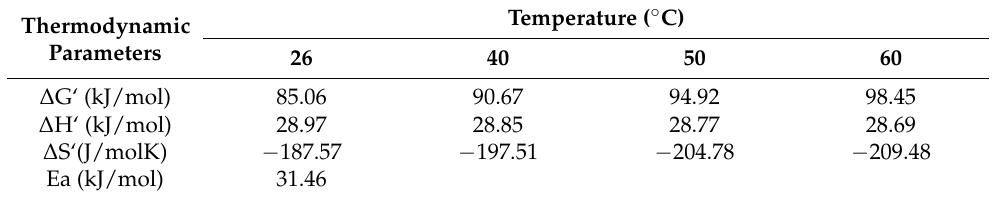
Table 5. Thermodynamic properties for Nudrin removal by for WSD:Mag-based oxidation process. Thermodynamic